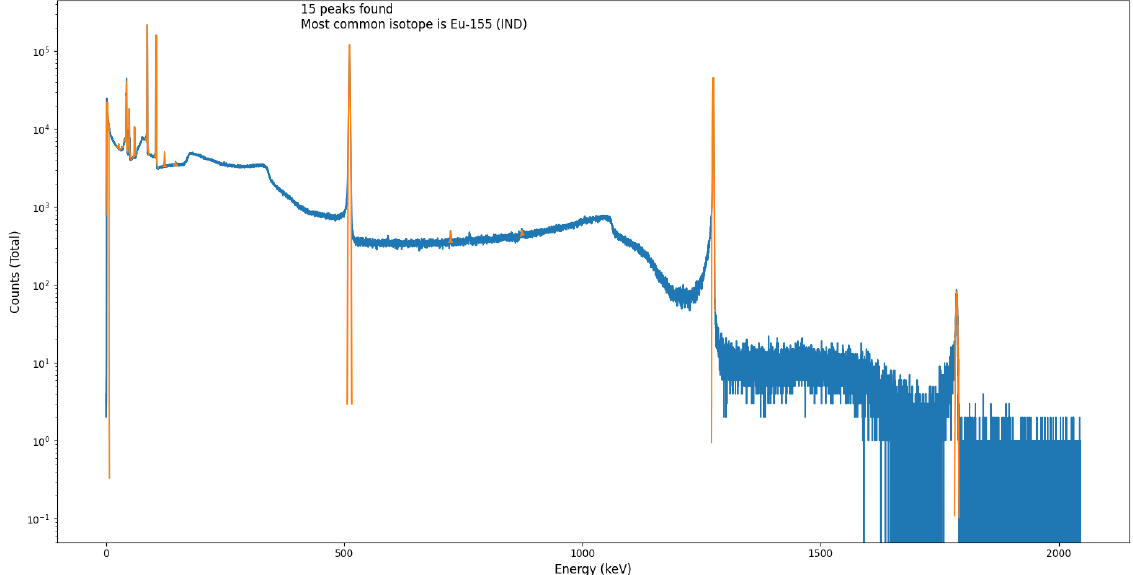
Figure 11. Peak-identified gamma-ray spectrum with counts on a log scale, analysed after data collection (post-processed), for a Eu-155 and Na-22 mixed source obtained using a SAGe™ Well detector. The table comprises the same nomenclature as detailed formerly in Figure 5 The duration of data collection was 5 min